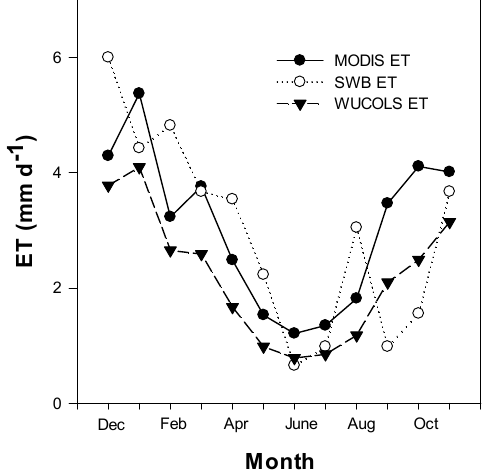
Figure 4. ET at Veale Gardens from December 2011 to November 2012 estimated by MODIS, soil water balance (SWB) and Water Use Classification of Landscape Plants (WUCOLS) methods.